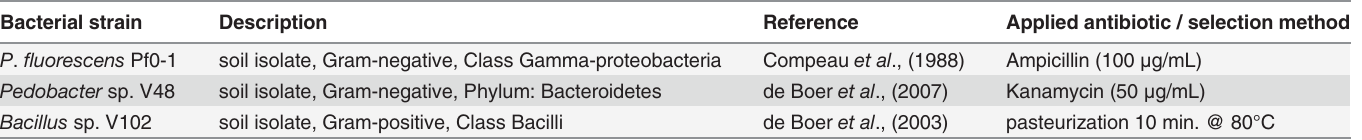
Table 1. Bacterial strains and used antibiotics / selection method applied in the selective cell counting. Bacterial strain